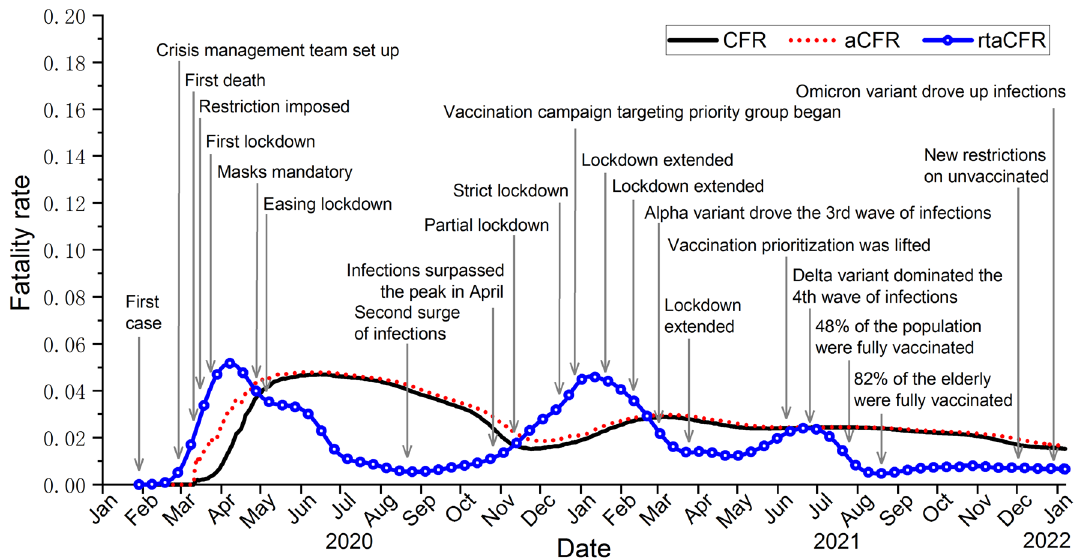
Figure 4. Estimates based on rtaCFR, aCFR and CFR for the outbreak of COVID-19 in